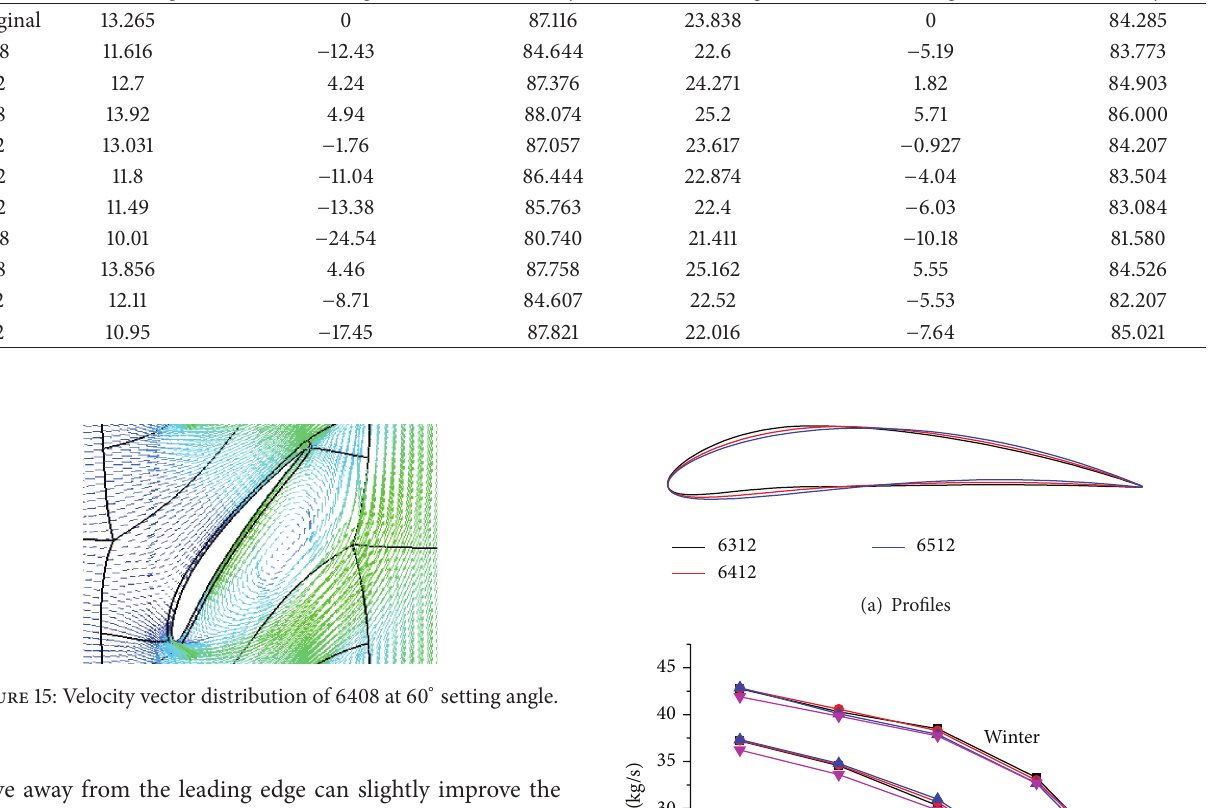
Table 2: Mass flow, the mass flow rate change ratio, and efficiency at 60 ∘ setting angle. Profile